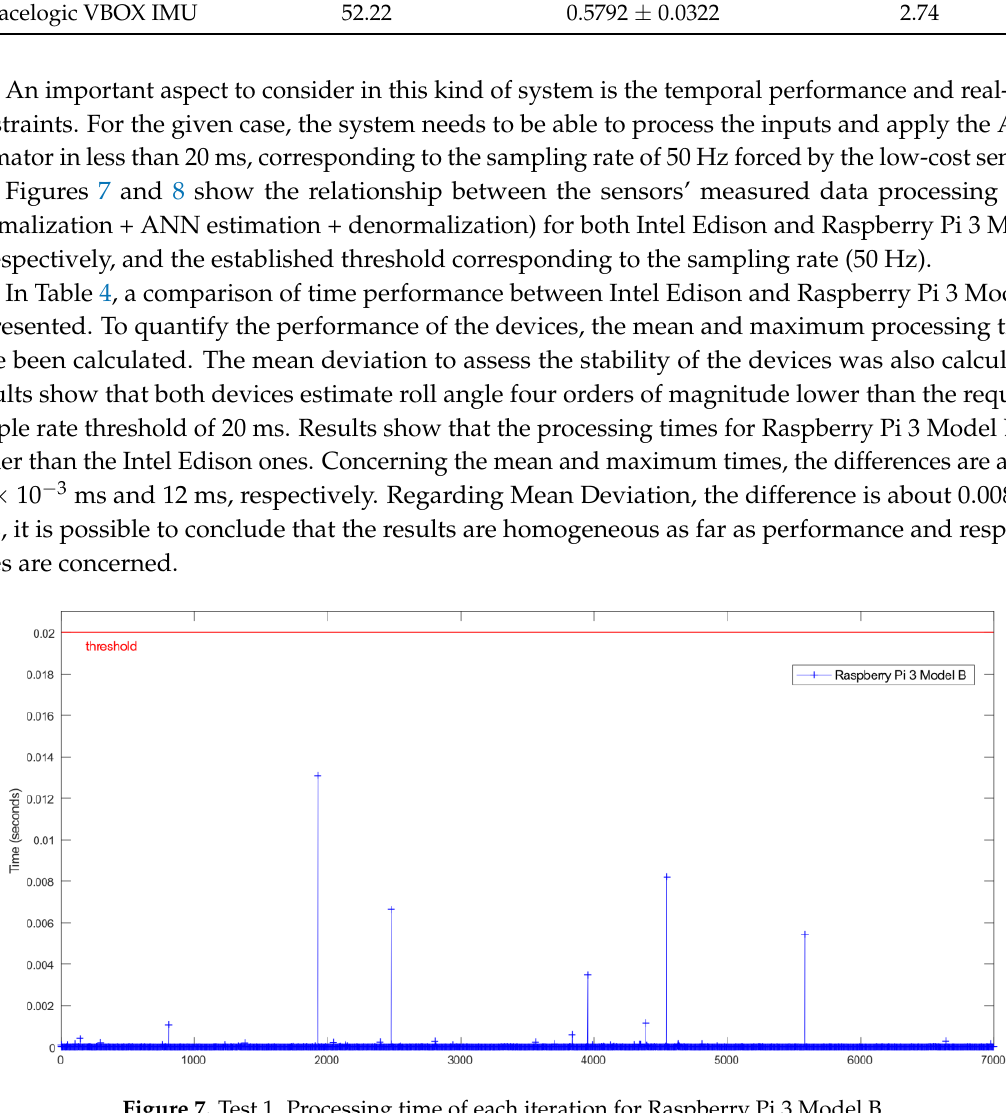
Figure 7. Test 1. Processing time of each iteration for Raspberry Pi 3 Model B.